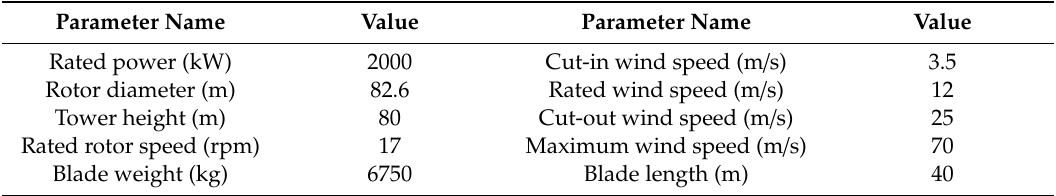
Table 2. Parameters of the 2 MW wind turbines investigated in this